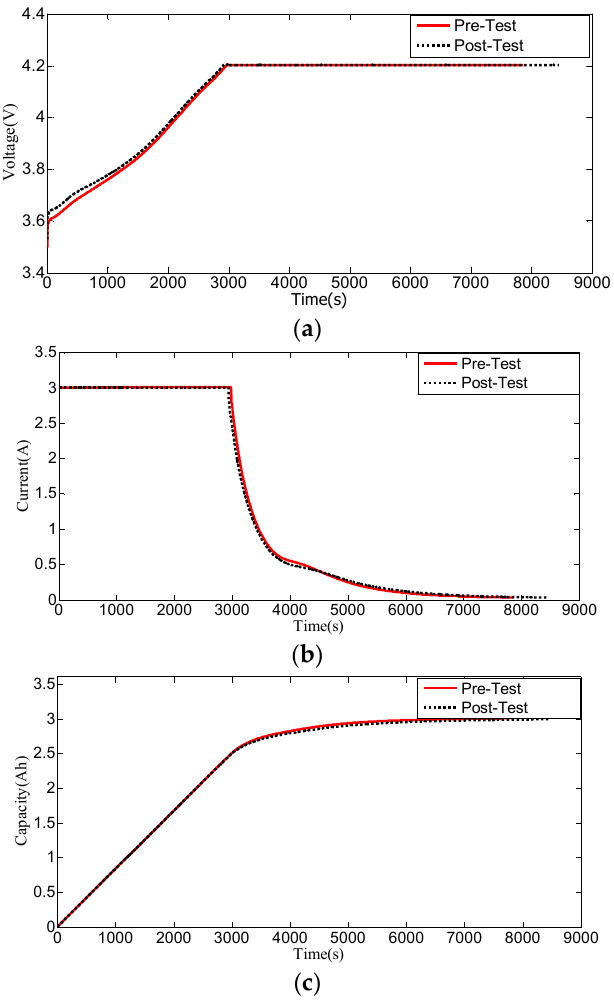
Figure 12. Constant current constant voltage charging process. ( a ) Voltage variation of the constant current and constant voltage (CC-CV) charging; ( b ) Current variation of the CC-CV charging; ( c ) Capacity variation of the CC-CV charging.